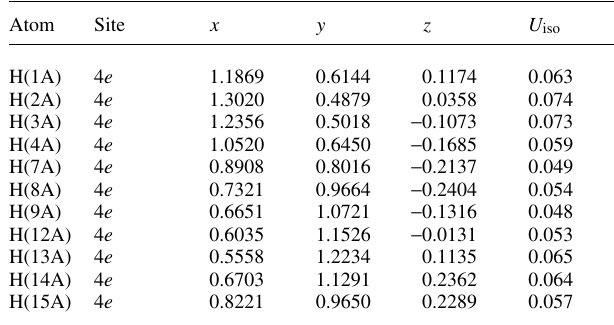
Table 2. Atomic coordinates and displacement parameters (in Å 2 ) . Table 1. Data collection and